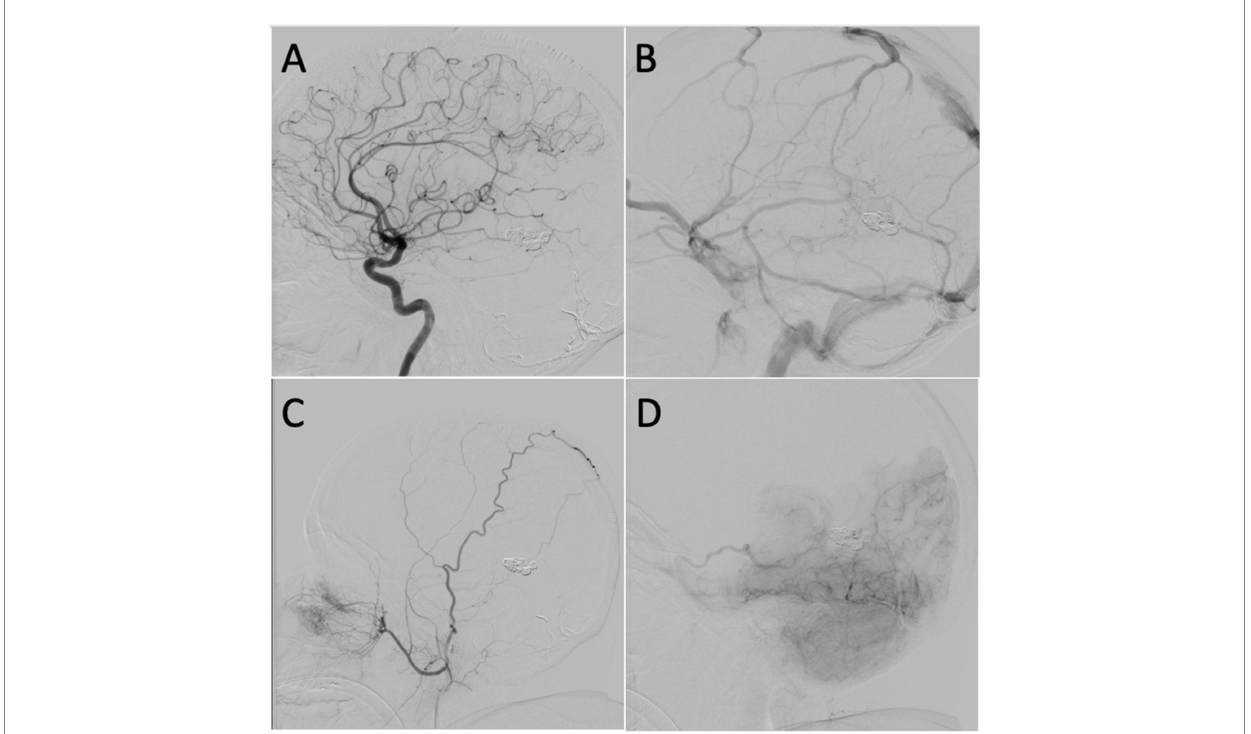
FIGURE 4 (A) Lateral projection of the left ICA, arterial phase, showing no shunting. (B) Lateral projection of the left ICA, venous phase, showing improvement in the overall venous congestion. (C) Lateral projection of the right ECA showing mild shunting from the falcine artery. (D) Lateral projection of the right vertebral artery, early venous phase, showing mild shunting from the posterior choroidal artery with venous drainage through the basal vein of Rosenthal and left superior ophthalmic